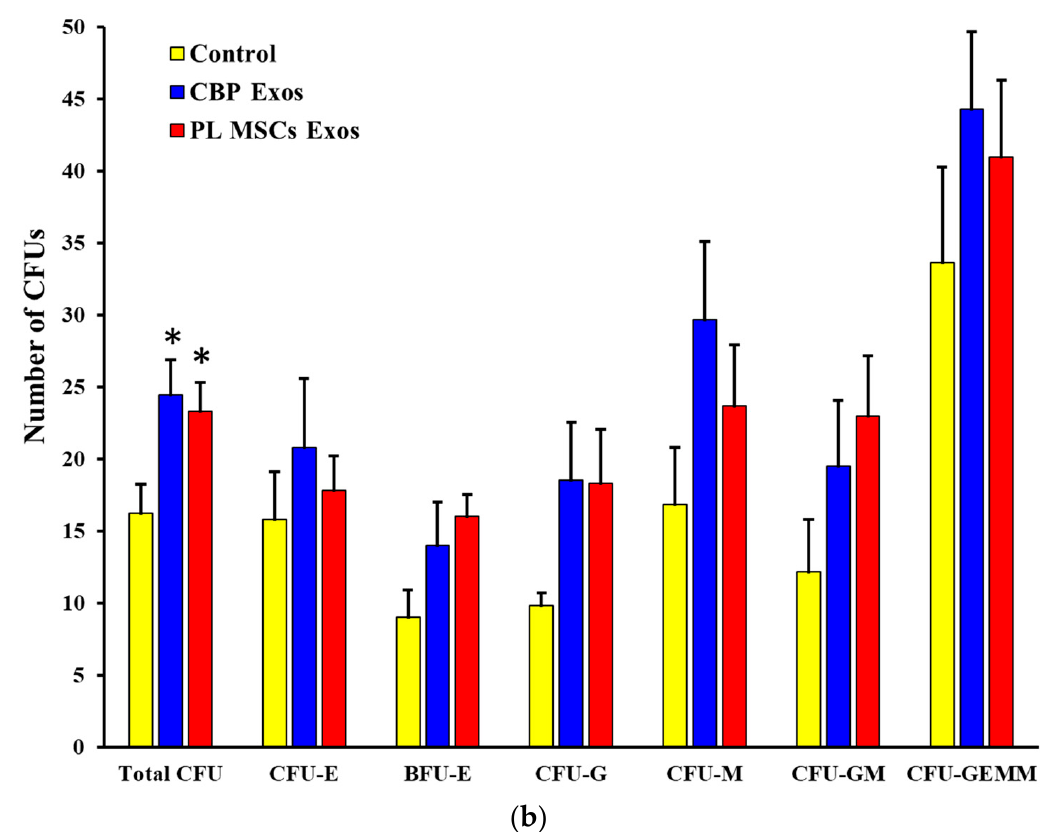
Figure 6. The effects of CBP and PL MSCs exosomes on the generation of CFUs from the expanded CD34 + cells. Day 10 expanded cells were plated in semi-solid cellulose media for another 14 days ( n = 3, 3 replicates each). ( a ) Typical morphology of CFUs, observed using an inverted microscope. ( b ) Comparison of individual CFUs and average of total number of CFUs generated in the three groups after 14 days of expansion. CBP: cord blood plasma; PL MSCs-Exos: placenta mesenchymal stem cells-derived exosomes; CBP-Exos: cord blood plasma-derived exosomes. * p <